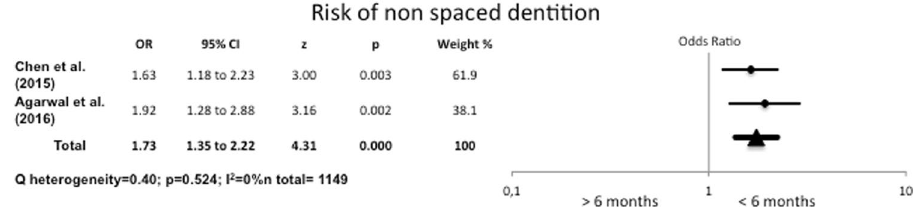
Figure 7. Odds Ratio for non-spaced dentition, comparing breastfeeding for < 6 months with breastfeeding for > 6